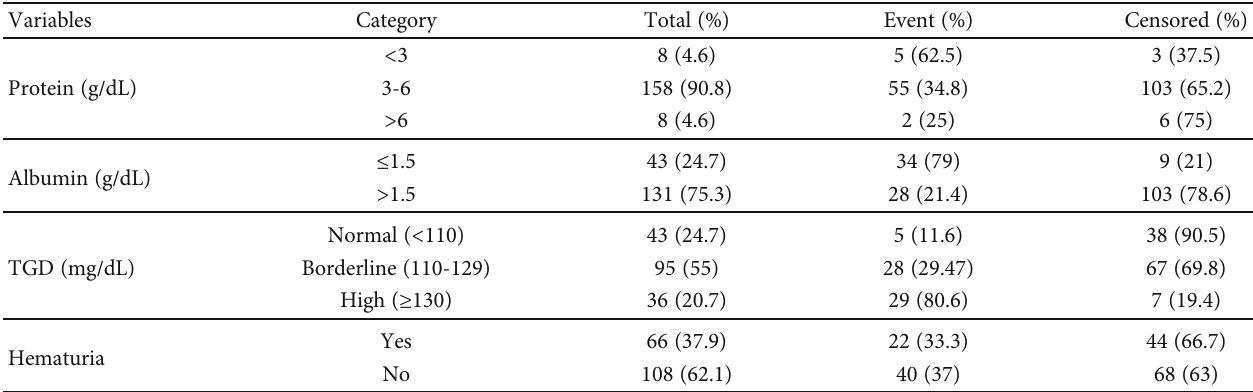
Table 3: Distribution of biochemical-related characteristics among children with nephrotic syndrome in comprehensive specialized hospitals of Tigray region, Northern Ethiopia, 2019 ( N = 174